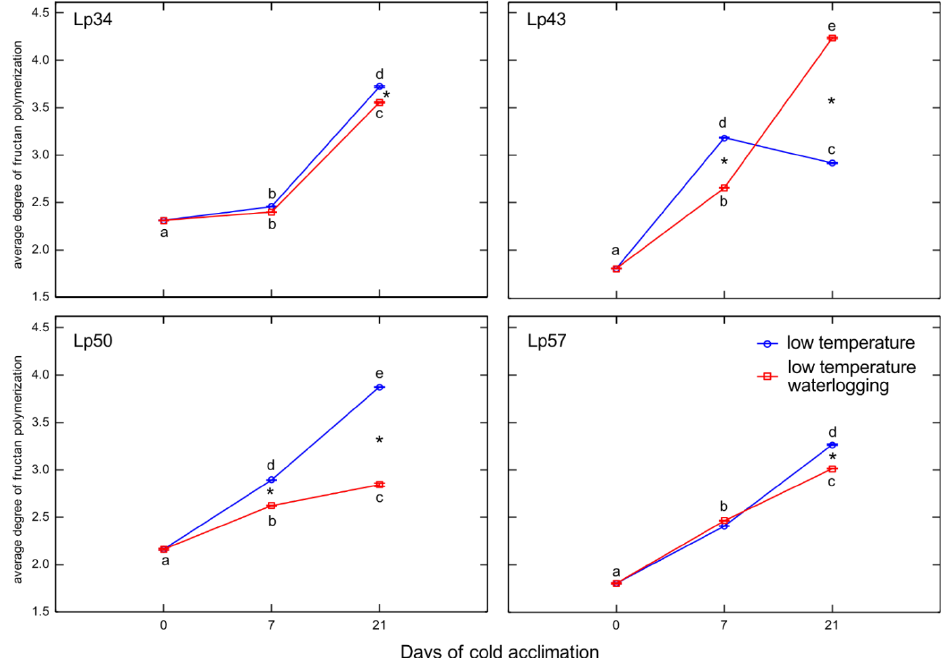
Figure 9. Average degree of polymerization of total fructans of cold-acclimated Lolium perenne genotypes. Four genotypes (Lp34, Lp43, Lp50, and Lp57) were tested. The results are means ( n = 4), error bars indicate the standard error. Asterisks indicate means that differ significantly between waterlogged and control plants according to one-way ANOVA ( p < 0.05). Different lower-case letters indicate means that are statistically different according to Duncan’s multiple range test ( p < 0.05).